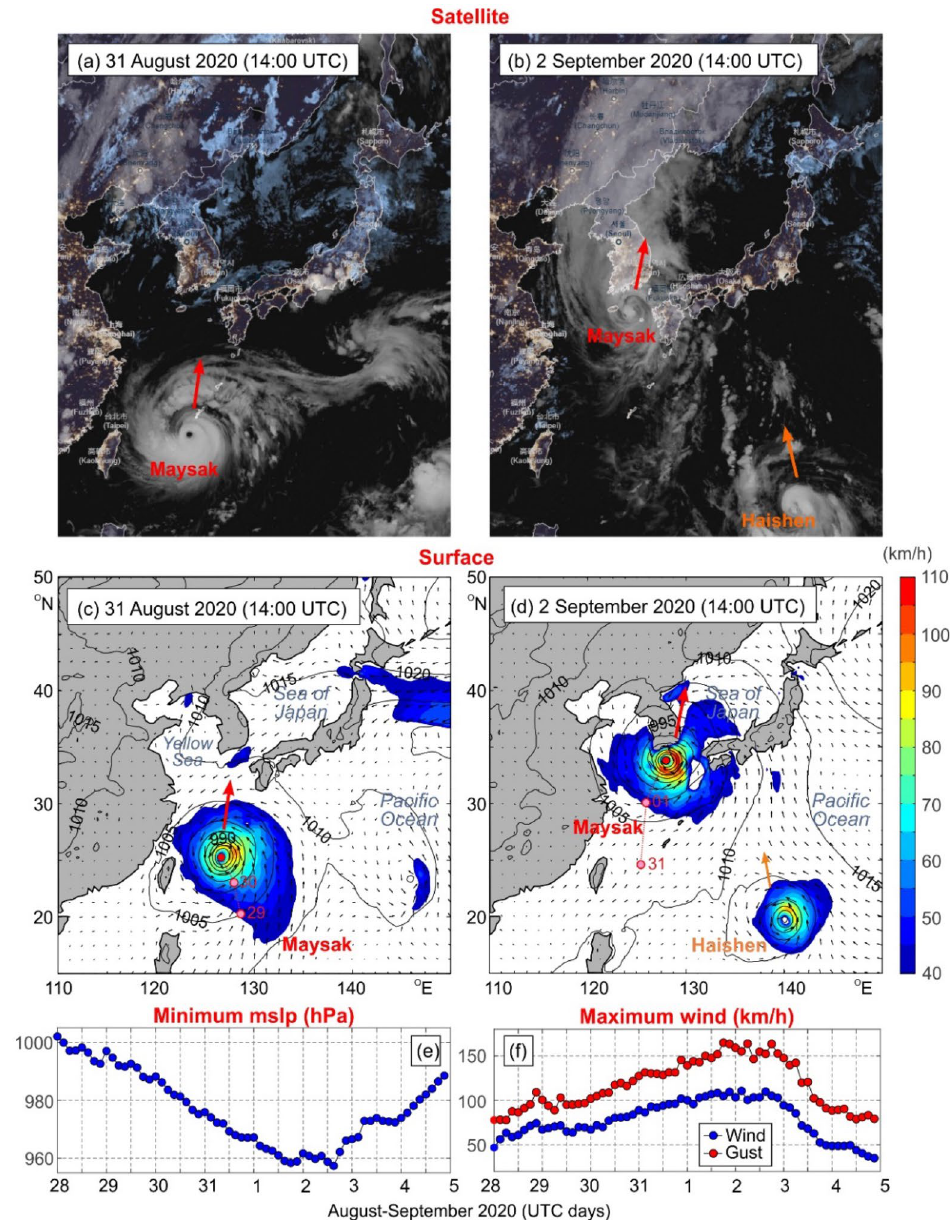
Figure 1. Satellite images of typhoon Maysak on ( a ) 31 August and ( b ) 2 September 2020; the thick red arrows show the direction of the typhoon propagation. The surface air pressure (hPa) and wind velocity (km/h) maps during typhoon Maysak for the east coast of Asia on ( c ) 31 August and ( d ) 2 September 2020 (from ERA5 Reanalysis); only wind speeds greater than 40 km/h are coloured. The red and pink circles show the typhoon center at current and previous dates, respectively; in the right bottom corners of ( b ) and ( d ) typhoon Haishen is shown to appear. ERA5 values of Maysak-related ( e ) minimum mean sea level air pressure (MSLP) and ( f ) maximum 10-m wind speed (blue) and wind gust (red). Satellite images were downloaded from ventusky.com. Maps were created with MATLAB 2021. Subplots were combined and edited with CorelDraw